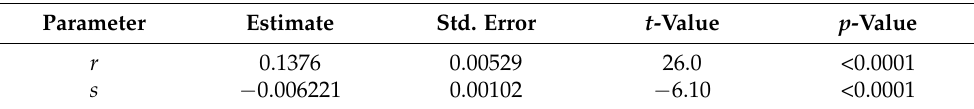
Table 10. Parameter estimates of the model for predicting MTH from mean height (Equation (11)). The root mean square error = 1.97 m on 710 degrees of freedom.